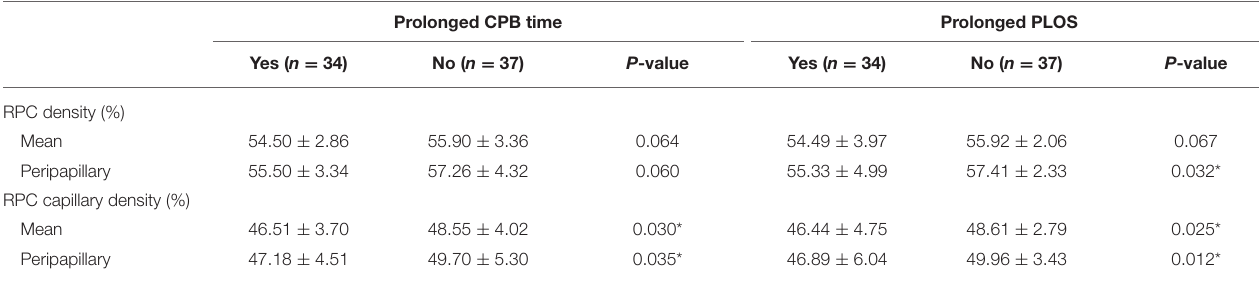
TABLE 7 | Comparison of preoperative retinal vessel density in patients with and without prolonged CPB time and